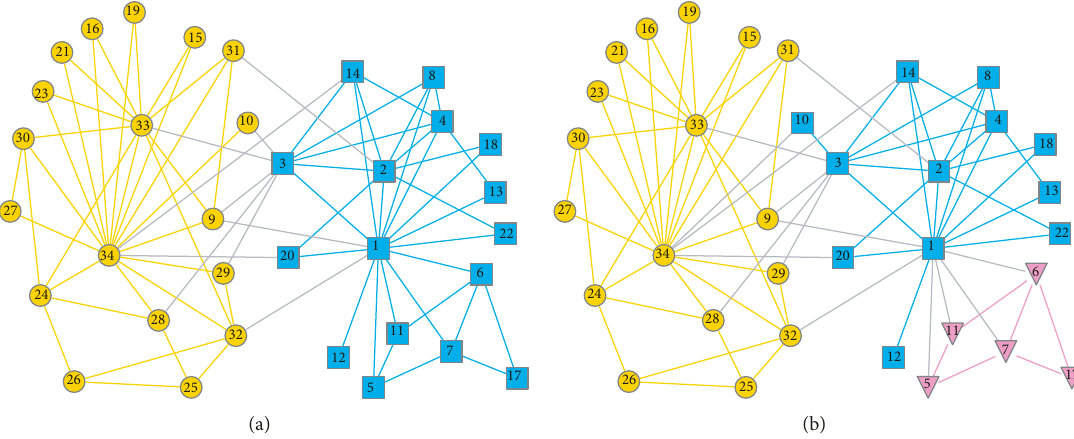
Figure 4: The karate club network . (a) The ground-truth community structure. (b) The community structure detected by our proposed method, NSA. (The nodes in different communities are plotted in different colors and shapes; this illustration style is also applied in the subsequent